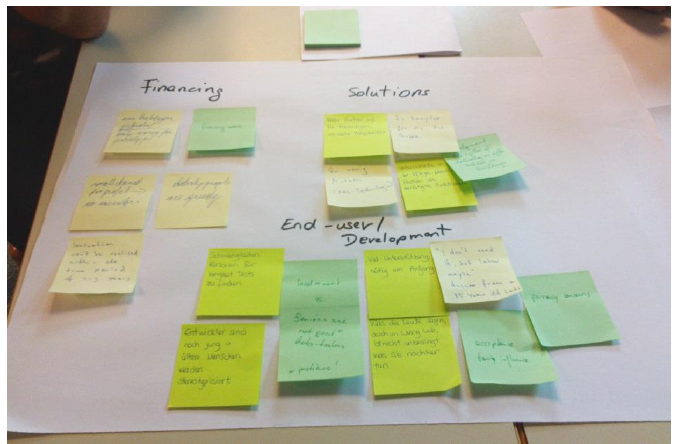
Figure 5. Categorization of issues (from workshop 2, group b). Table 1. Categories from the workshops. The number of issues for each category is displayed in